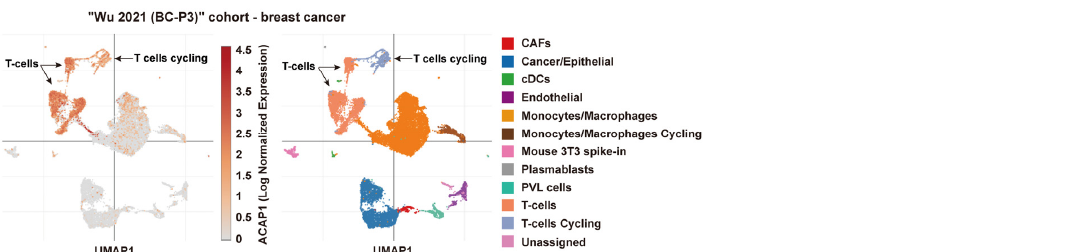
Figure 2. Single-cell gene expression analysis of ACAP1. ( A , B ) Single-cell RNA sequencing anal- yses of ACAP1 mRNA expression across various cell types in melanoma datasets GSE72096 and GSE115978. ( C ) Single-cell expression patterns of ACAP1 in the glioblastoma dataset “Neftel 2019” are shown with tSNE plots. ( D , E ) Single-cell expression patterns of ACAP1 in prostate cancer datasets, including “He 2021” and “Wu 2021 (PC-P1)”, are shown with UMAP plots. ( F ) Single-cell expression patterns of ACAP1 in the cutaneous melanoma dataset “Wu 2021 (M-P1)” are shown with UMAP plots. ( G – I ) Single-cell expression patterns of ACAP1 in breast cancer datasets, including “Wu 2021 (BC-P1)”, “Wu 2021 (BC-P2)”, and “Wu 2021 (BC-P3)”, are shown with UMAP